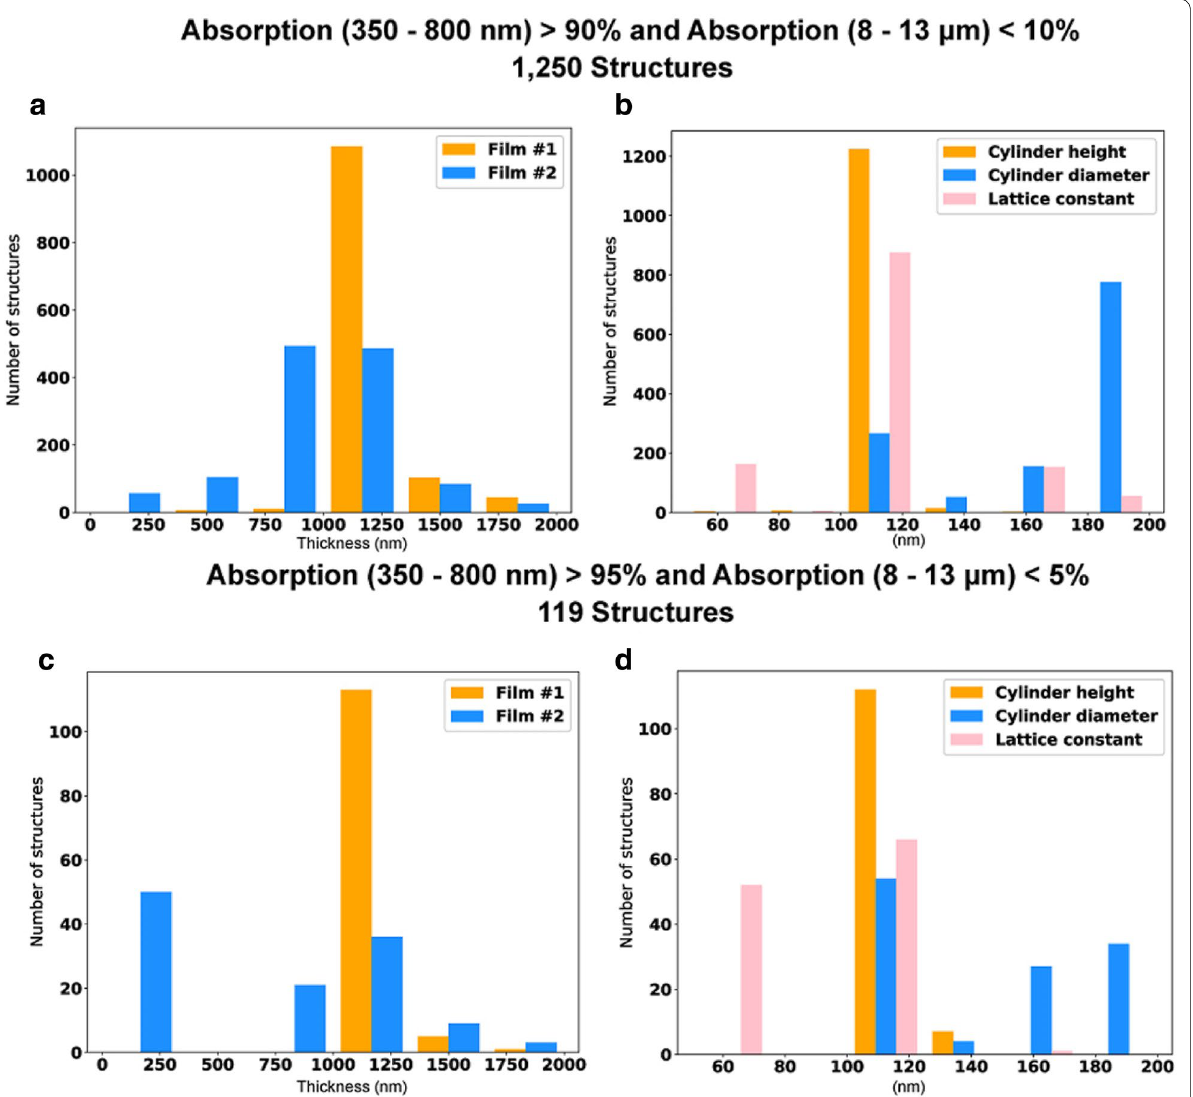
Fig. 2 a, c Histograms of film #1 and film #2 thickness distributions, and b, d cylinder height, diameter, and lattice constant distributions for two criteria. a, c show the distributions for the structures with an AUC higher than 90% from 350–800 nm and lower than 10% from 8–13 μm (1,250 structures). b, d show distributions structures with an AUC higher than 95% from 350–800 nm and an AUC lower than 5% from 8–13 μm (119